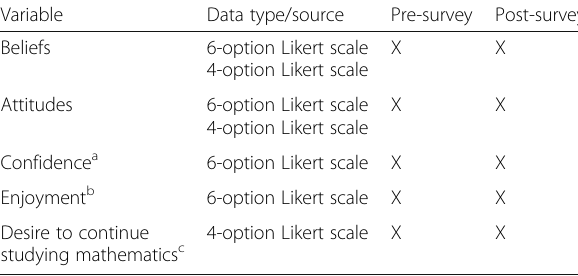
Table 2 Dependent